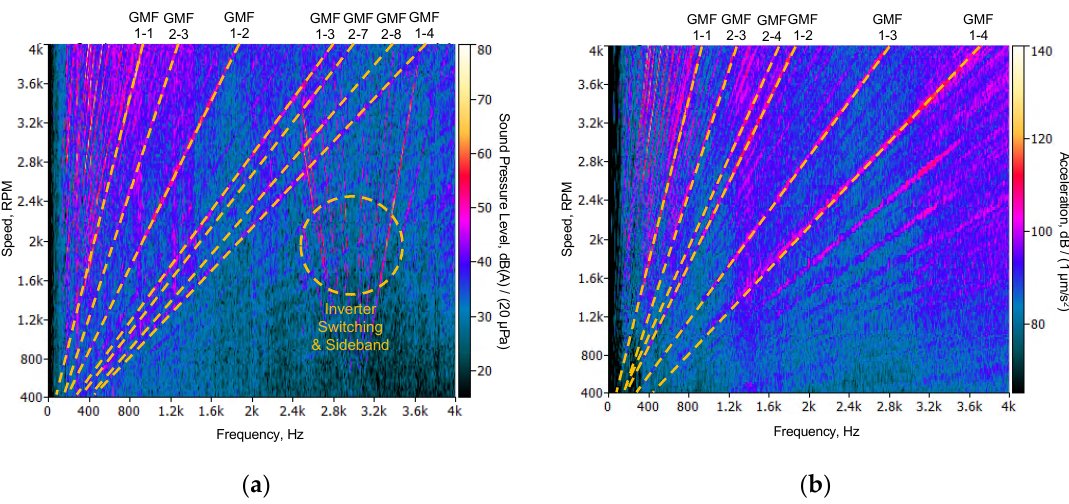
Figure 5. Order analysis of the noise and vibration with gear mesh frequency (GMF). ( a ): Sound pressure level; ( b ): Acceleration level.